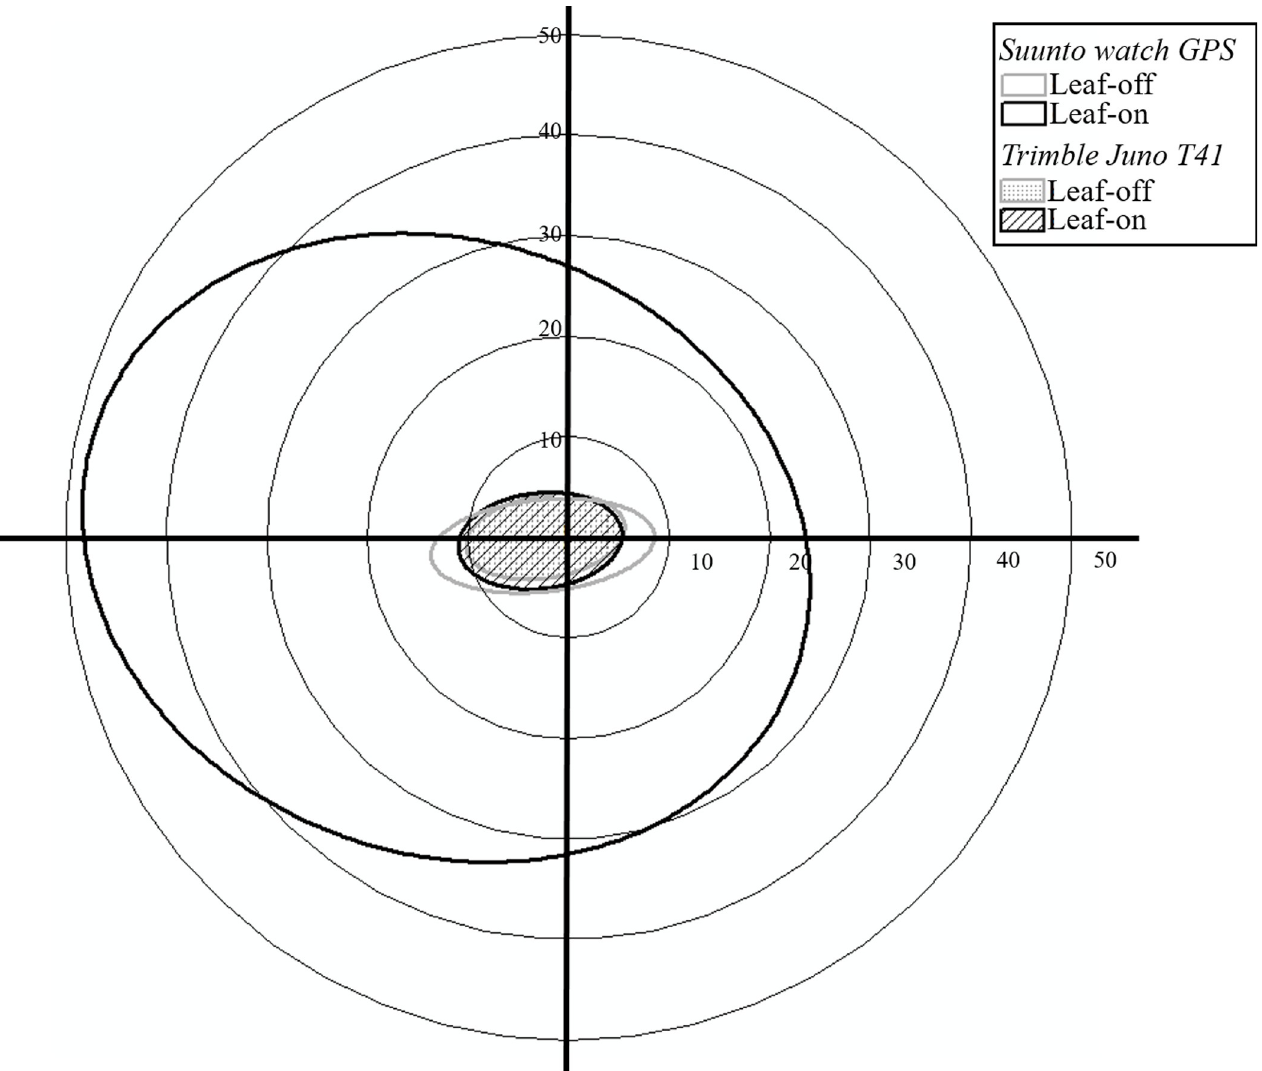
Fig 3. The distributions and standard deviational ellipses of translocated GPS points data obtained by different types of equipment during different seasons.